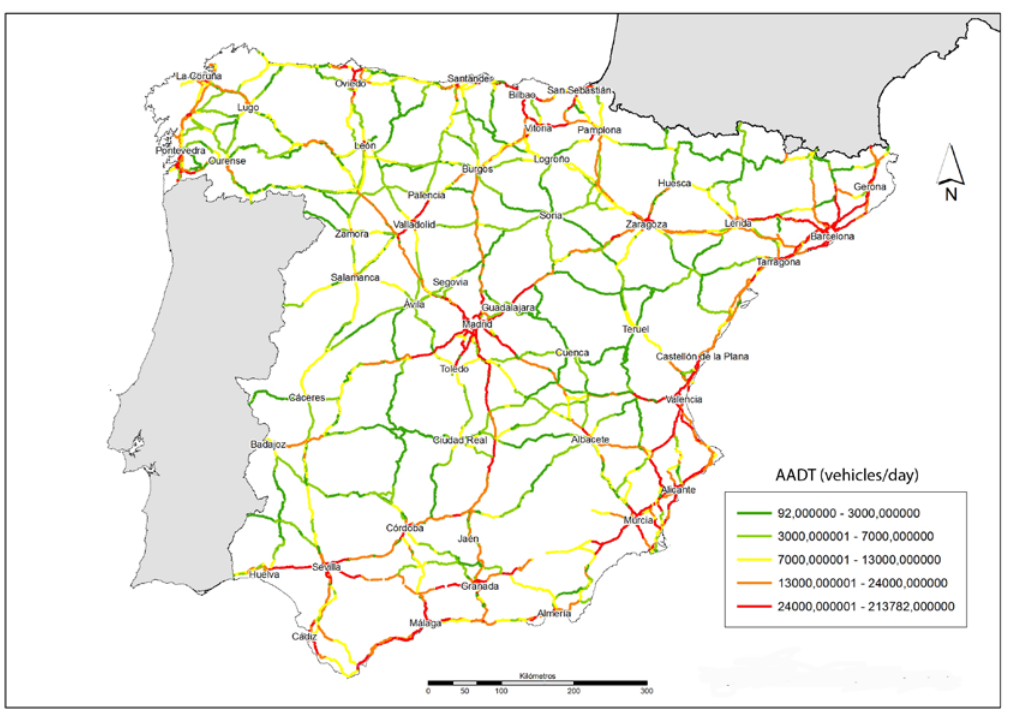
Figure 5. Road-network in Spain by AADT (vehicles/day). Source: MFO, 2009; and this study. Table 7. Road freight transport and main highway corridors in Spain Section/node